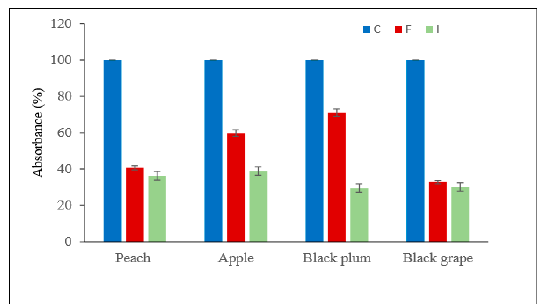
Figure 8. Absorbance% changes in all fruit juice filtrates control, treated with free and immobilized pectin